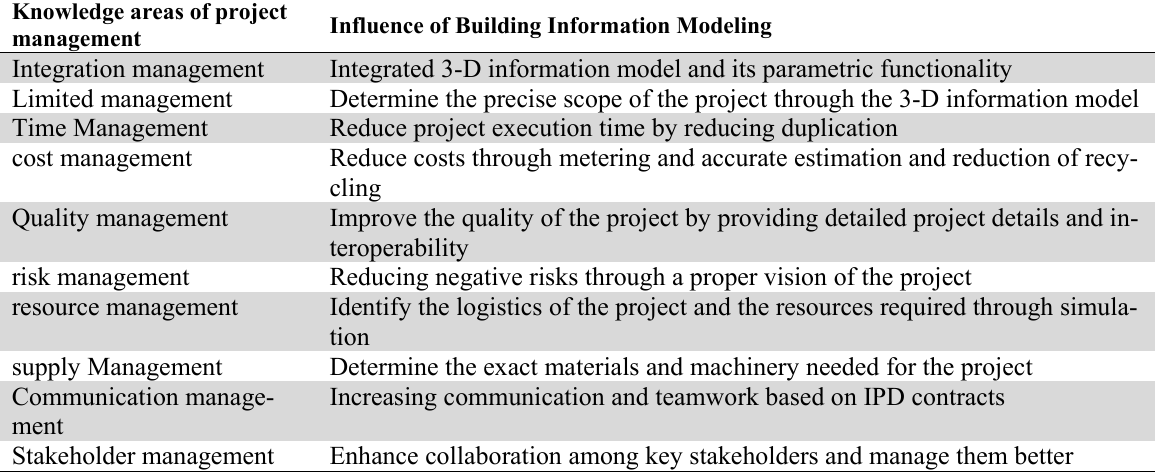
Summary of the Effects of Building Information Modeling Capabilities on Project Management Knowledge